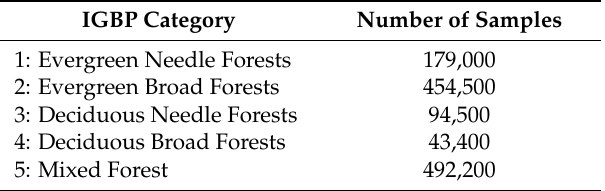
Table 4. Number of samples for the average BBE climatology statistics over IGBP categories shown in Table